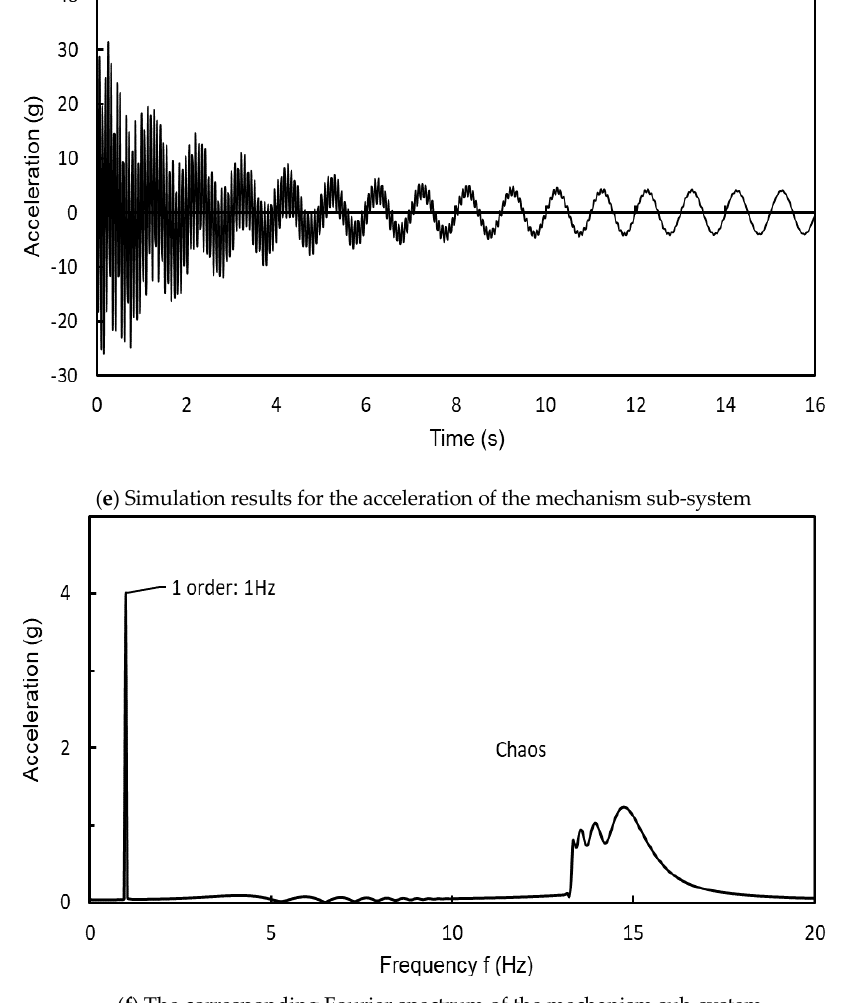
Figure 8. Simulation results for the acceleration and the corresponding Fourier spectrum of the VEAM.